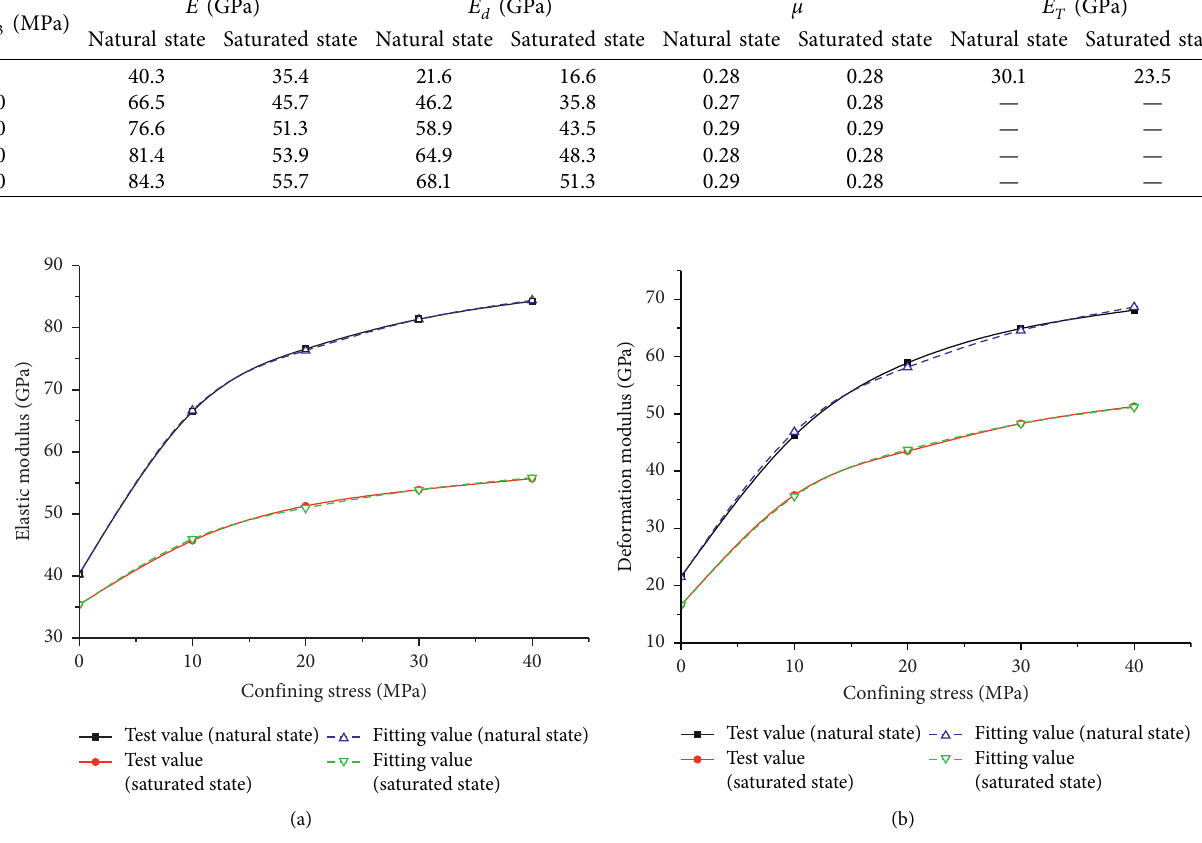
Figure 7: Relationships between elastic modulus, deformation modulus, and confining pressure for two water content states. (a) Elastic modulus versus confining pressure. (b) Deformation modulus versus confining